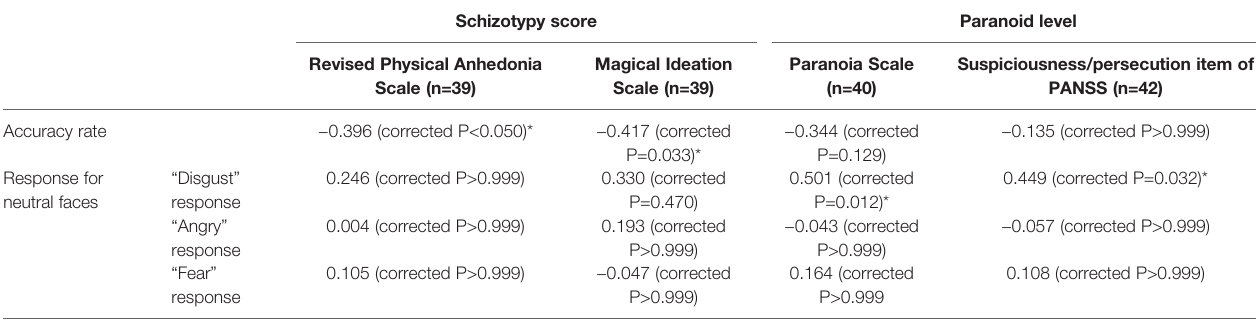
TABLE 3 | Correlation coef fi cients for the associations between accuracy rate of facial emotion recognition/threat-related emotion response rates for neutral faces and schizotypy scores and paranoia level in individuals at ultra-high risk for